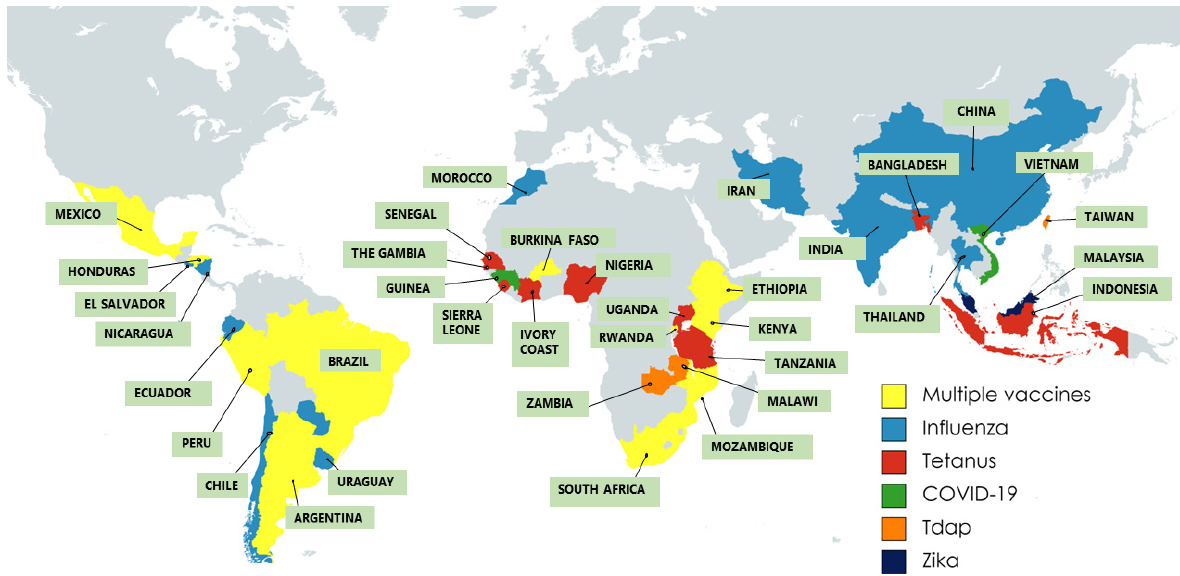
Figure 2. Geographical distribution of the included studies, by vaccine type. Multiple vaccines refer to studies investigating administration of more than one maternal vaccine type. This figure refers only to the maternal vaccines reported in included studies and does not reflect the entirety of vac- cines available in the countries represented here . Tdap: tetanus, diphtheria, acellular pertussis